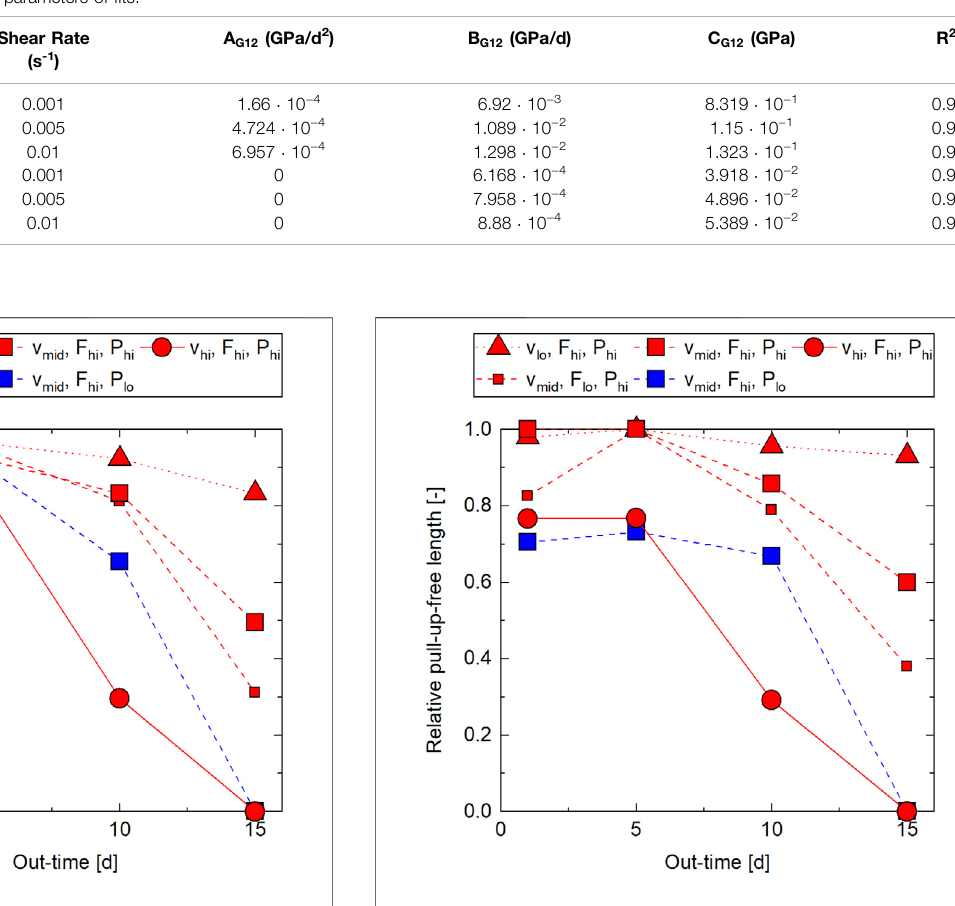
FIGURE 12 | Steering results — tape pull-up as a function of out-time from AFP lay-up experiments at steering radius R (cid:1) 600 mm (Material: IM7/ 8552 prepreg; out-time: 1 day – 15 days at T (cid:1) 21 ° C , RH (cid:1) 40 % ; v lo (cid:1) 0 . 03 m / s , v mid (cid:1) 0 . 06 m / s , v hi (cid:1) 0 . 1 m / s , F lo (cid:1) 200 N ,